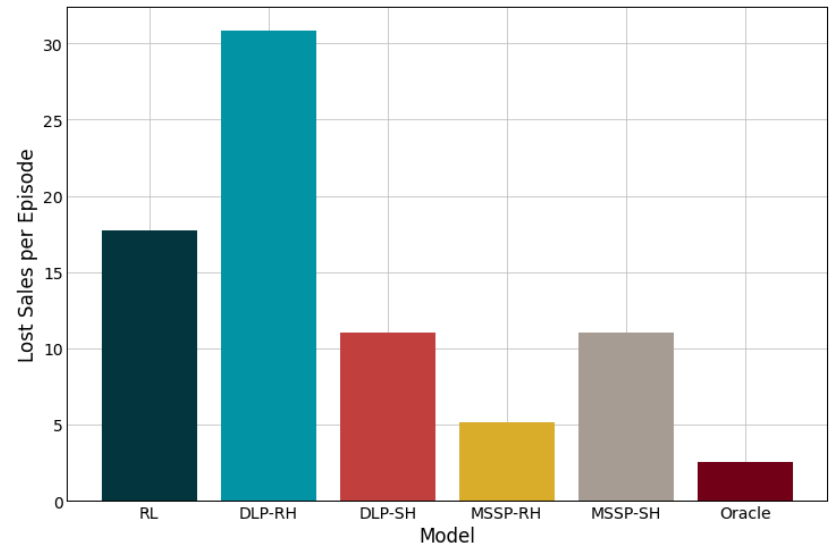
Figure 9. Average unfulfilled demands at the retailer node (lost sales